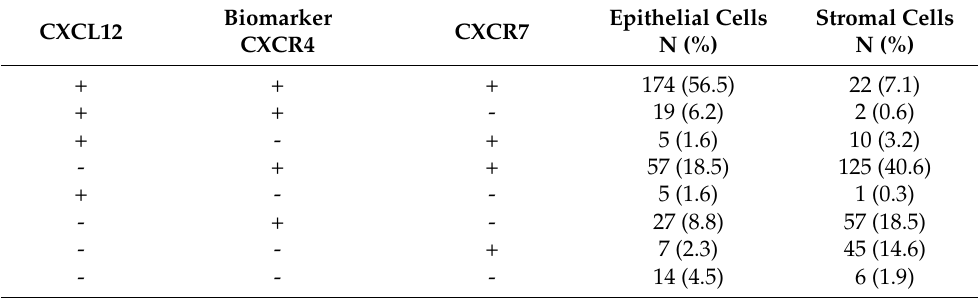
Figure 2. Decrease in stromal CXCR7 and CXCL12 in FIGO stage IV. Relative distribution of CXCR4- CXCL12-CXCR7 in EOC epithelial and stroma ( A ). CXCR4-CXCL12-CXCR7 percentage in epithelial and stromal cells (% of epithelial) in each H-score interval (X axes). Y axes showed the % of individuals with a given interval of CXCR4-CXCL12-CXCR7 expression. The median with interquartile range (IQR) was also reported, as a measure of central tendency for a skewed dataset. Box whisker plots showed the association between FIGO stage (stage III vs. IV) and CXCR4- CXCL12-CXCR7 expression ( B ). Table 1. Biomarkers’ co-expression based on CXCR4, CXCL12, CXCR7 IHC